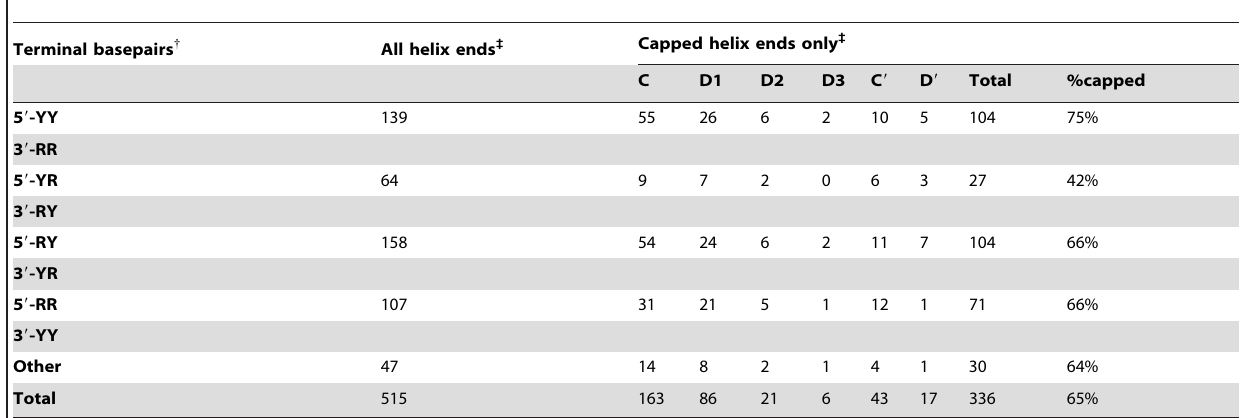
Table 3. Polarities of the last two terminal basepairs and their effect on helix capping.